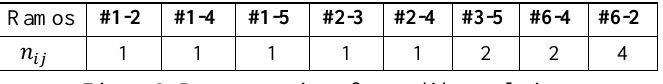
Figure 3: Representation of a candidate